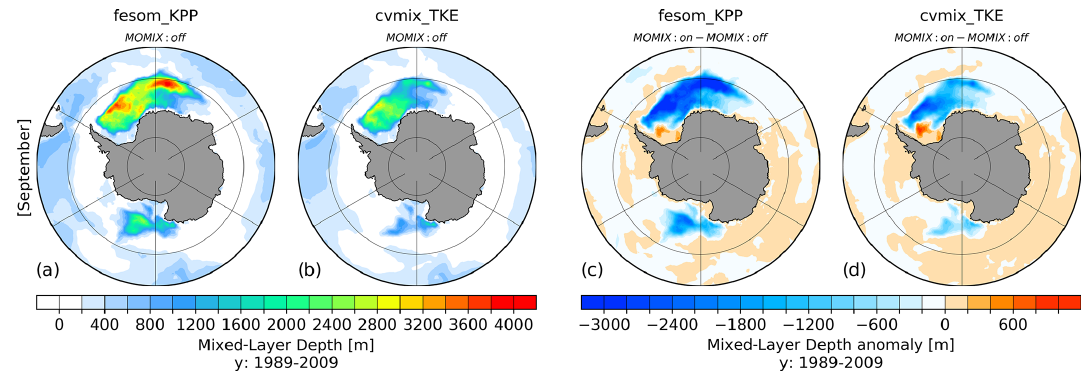
Figure 21. Southern Hemisphere September mixed-layer depth (MLD) for fesom_KPP (a) and cvmix_TKE (b) with switched-off Monin– Obukhov vertical mixing (MOMIX) parameterisation and the corresponding anomalous MLD between switched-on and switched-off MOMIX parameterisation ( c, d ) averaged for the period